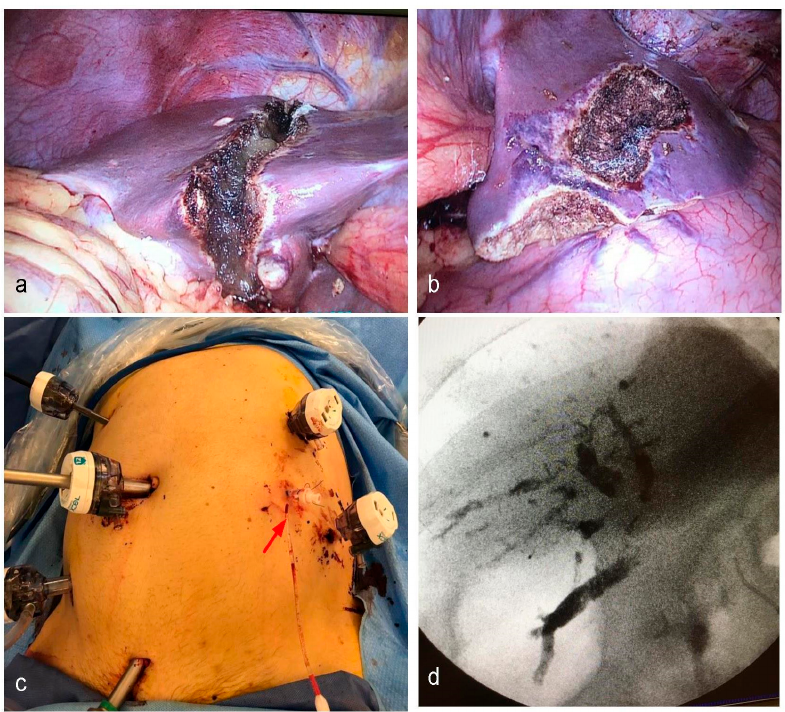
Figure 3. First stage of a simultaneous approach + Mini ALPPS in a patient with synchronous CRLM. ( a ) The transection line is shown on the right hemiliver. ( b ) The FLR has been cleared of multiple metastases. ( c ) The patient’s abdomen is shown for the sake of trocar placement. mini-ALPPS provides the benefit of a laparoscopic procedure, and can even assist in cannulation of the inferior mesenteric vein for PVE (red arrow). ( d ) Post-PVE portography that shows embolization material in all right portal